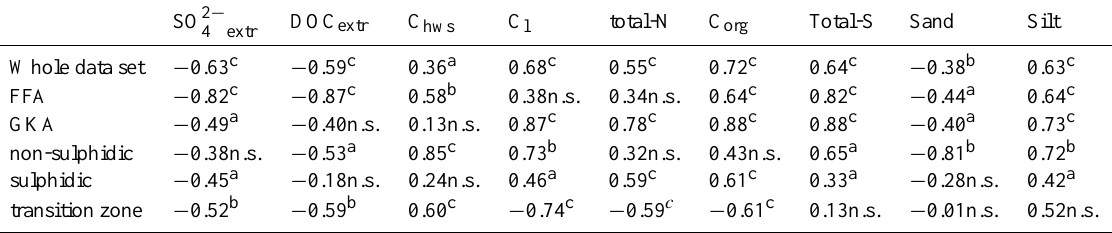
Table 3. Spearman rank correlation coefficients between D cum (365) and sediment parameters for the whole data set and partial data sets.